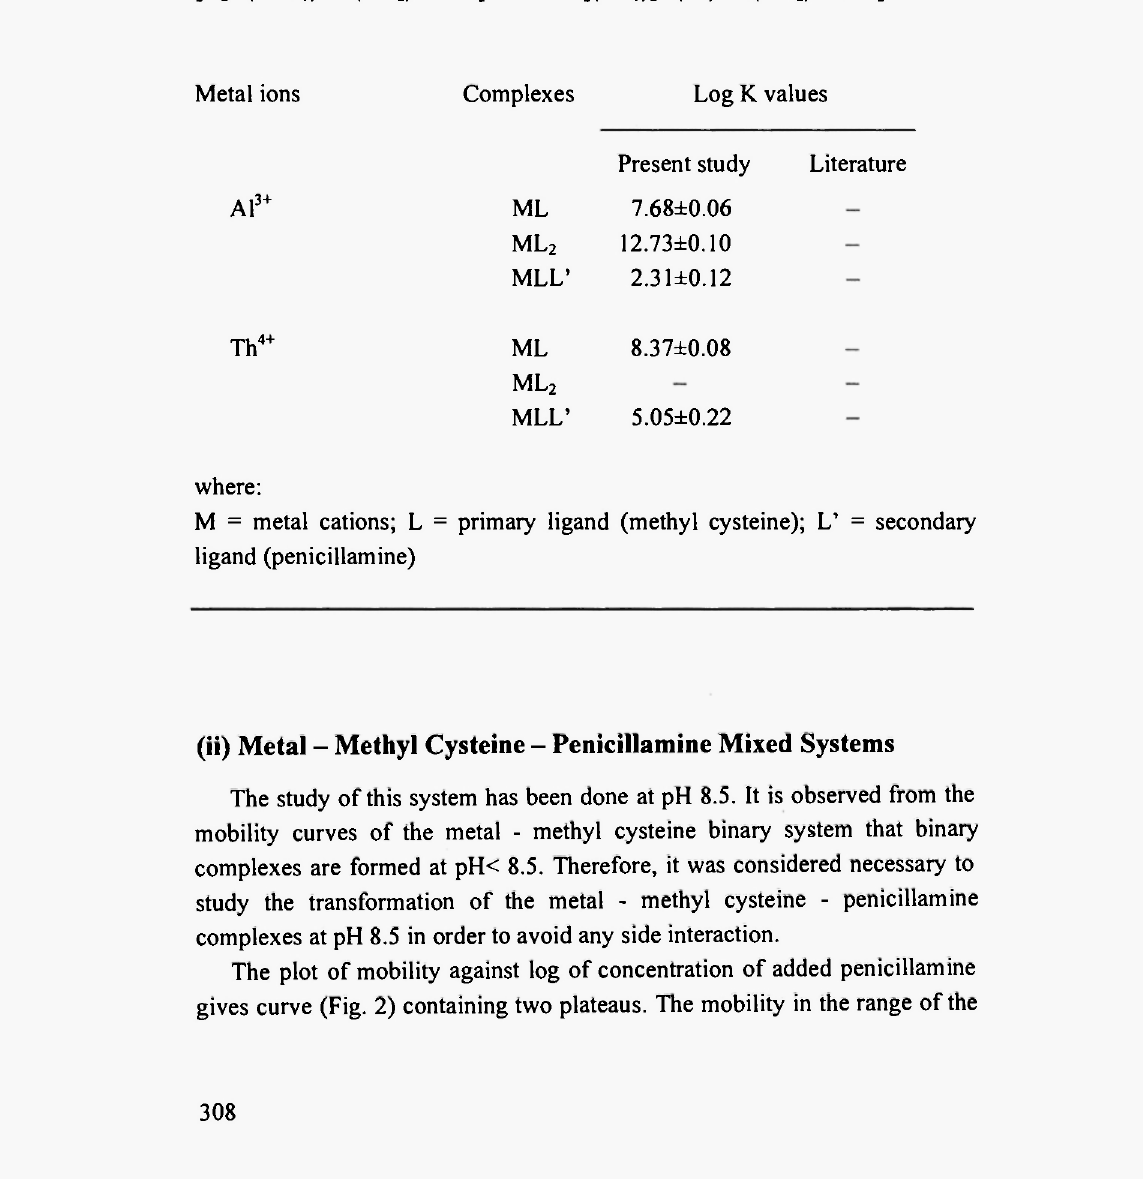
Stability constants of binary and mixed complexes of aluminium(III) and thorium (IV) Ionic strength =